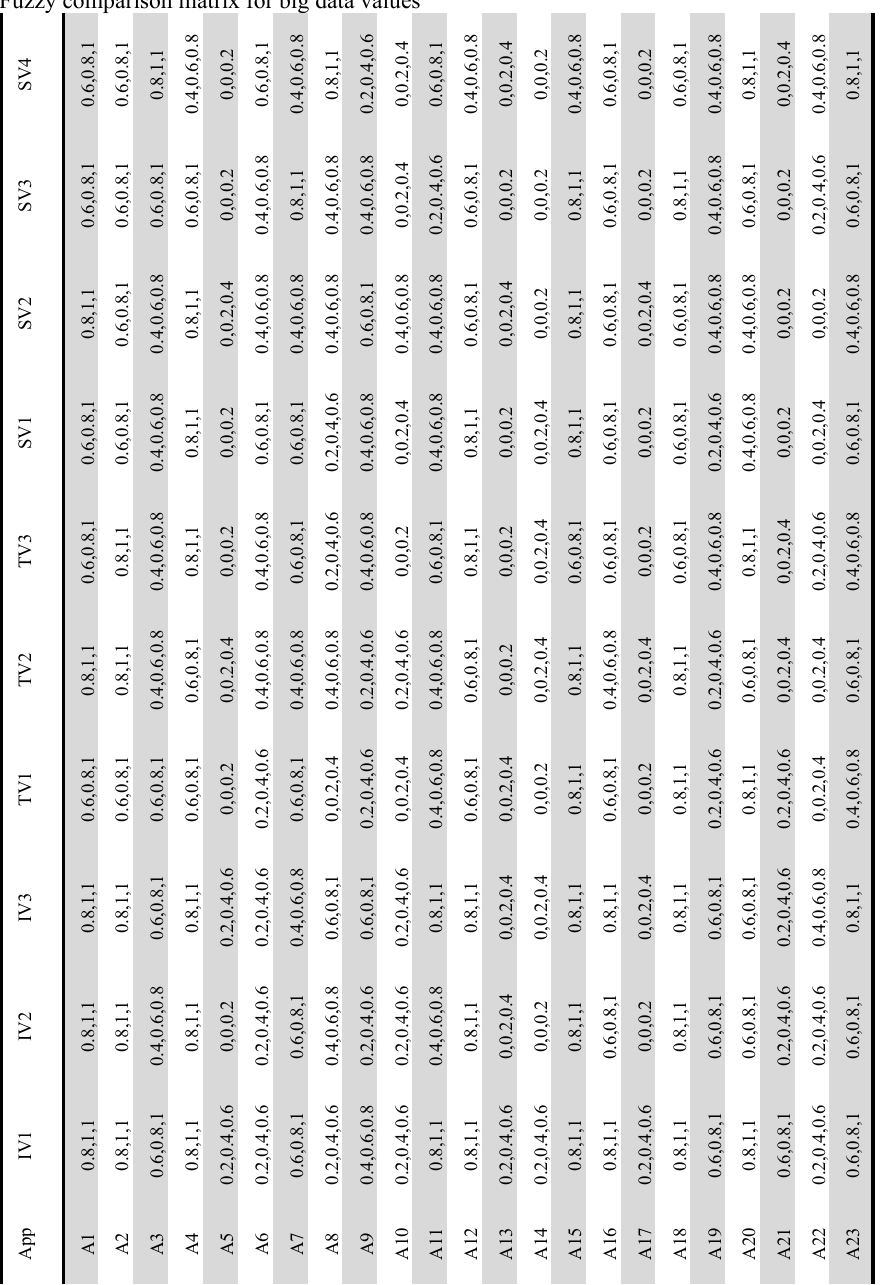
Fuzzy comparison matrix for big data